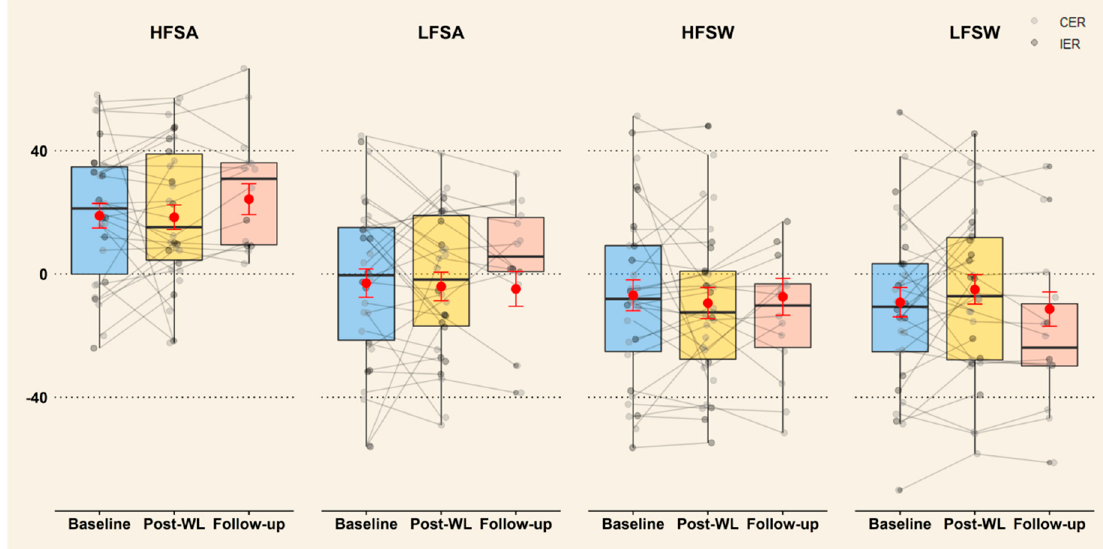
Figure 3. Change in wanting for all food categories after ≥ 5% WL and 1-year follow-up ( n = 28). The individual data are represented by points (light grey for CER and dark grey for IER) and showed that there was no difference between diets. Estimated means from the mixed models are represented by red points with error bar (SE). Boxplots represent the variability of the data with the median (black line), interquartile range (colored box) and whiskers representing minimum/maximum (Q ± 1.5 × QR). CER: continuous energy restriction, IER: intermittent energy restriction, HFSW: high-fat-sweet, HFSA: high-fat-savoury, LFSW: low-fat-sweet, LFSA: low-fat-savoury, WL: weight loss.